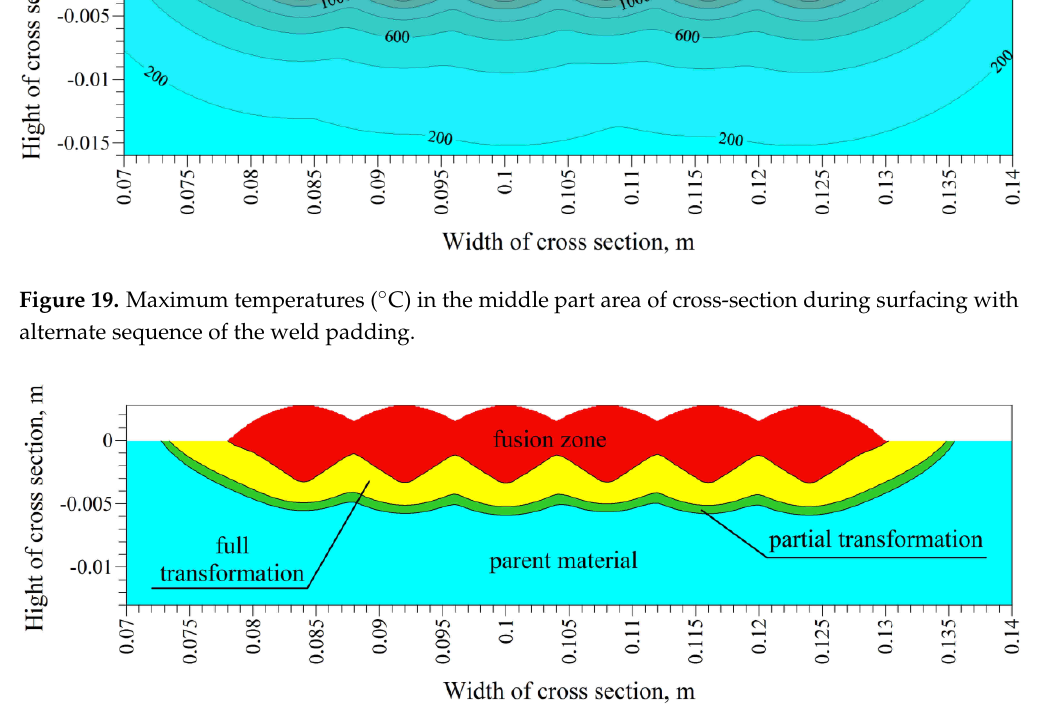
Figure 20. Heat ‐ affected zone after surfacing with alternate sequence of the weld padding.